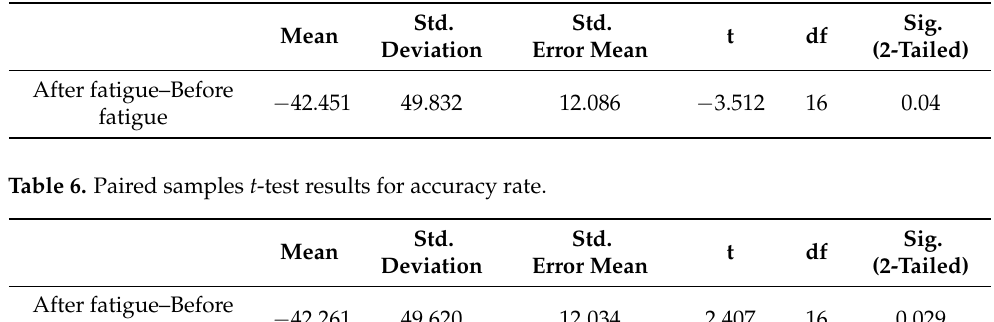
Table 5. Paired samples t -test results for reaction time.